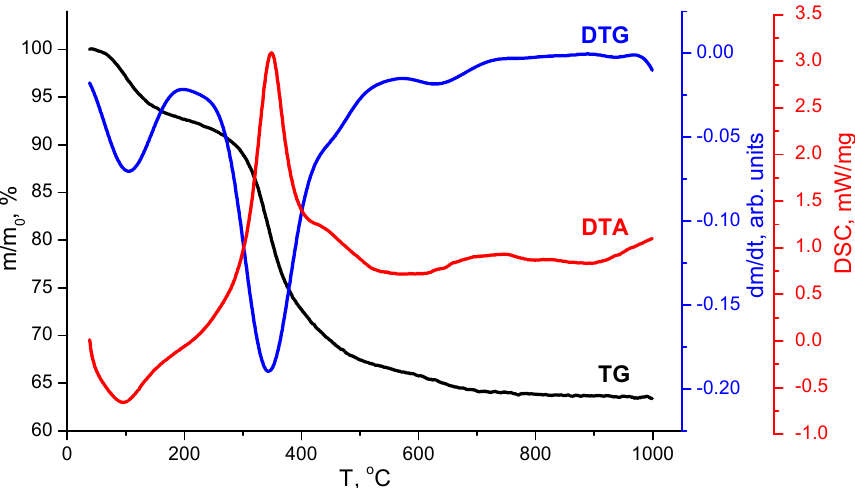
Figure 4. TA of fish scale powder enriched with inorganic components prepared from the mixture of fish scales using high-speed grinding and vibration sieving: TG (in black), DTG (in blue), and DTA (in red).